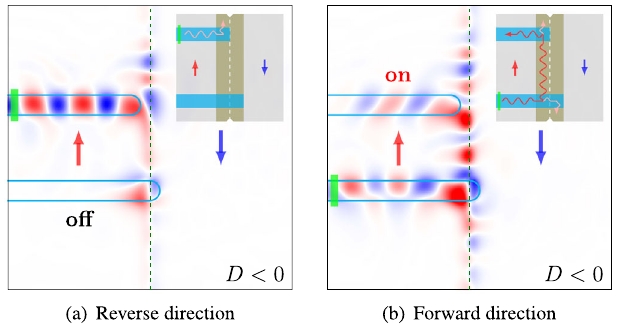
FIG. 4. Reprogramming the diode by changing the sign of the DMI parameter. The forward direction of the spin-wave diode for D < 0 is opposite to that for D > 0 in Figs. 2(g) and 2(h). The insets on the top right are the spin-wave propagation diagrams.